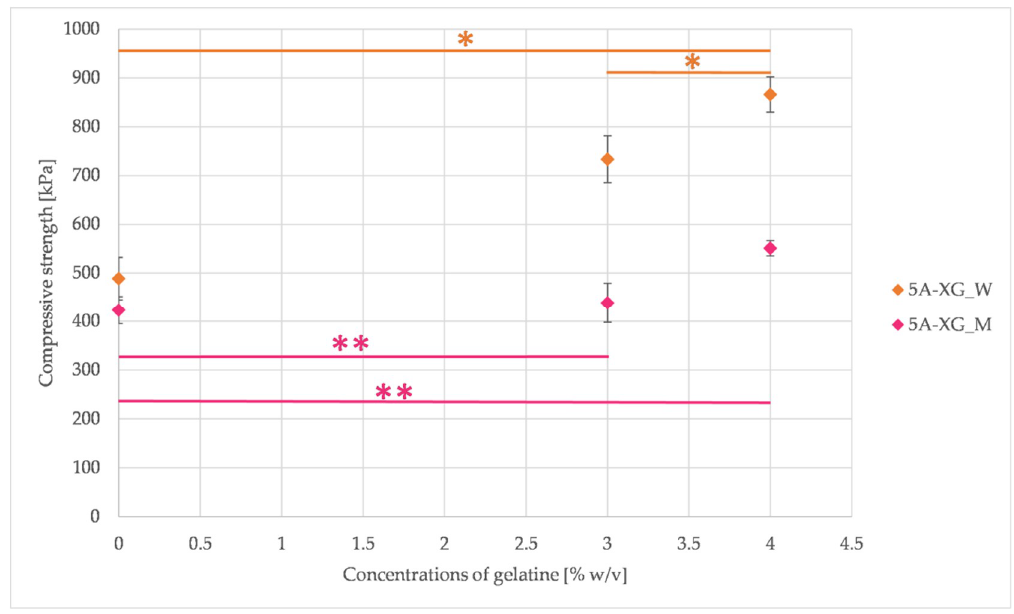
Figure 2. Compressive strength results for the samples dissolved in water (W) and full culture medium (M) with different content of gelatine (* = p < 0.05 and ** = p < 0.01, results statistically significant).